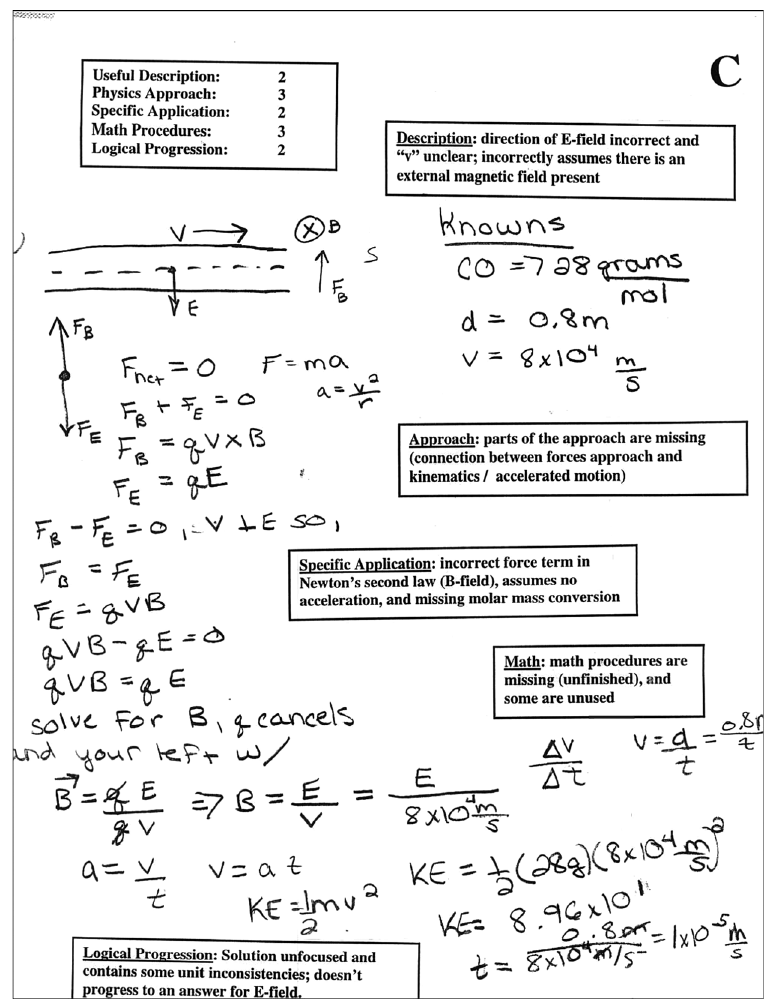
FIG. 3. Example of applying the MAPS rubric to a second student